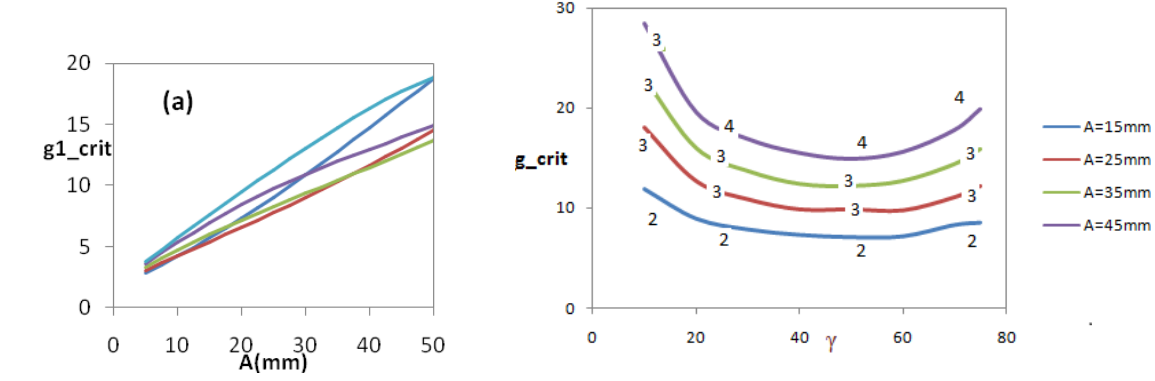
(c)Circular outer boundary. Isotropic growth.